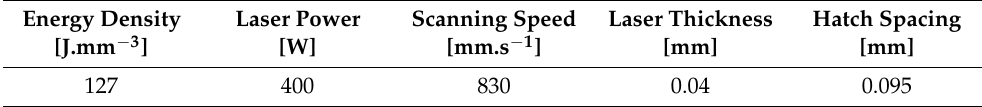
Table 2. Process parameters used for fabrication of the parts using SLM.